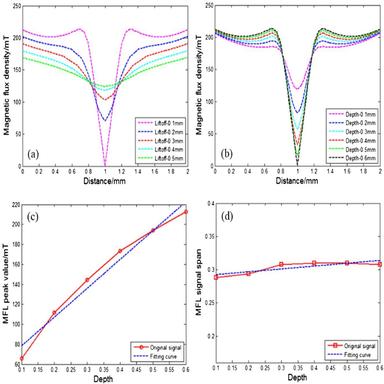
MFL signals and characterizations of triangular defect; (a) MFL signals of triangular defect in different liftoff values with the depth of 0.6 mm; (b) MFL signals of triangular defect in different depths with the liftoff of 0.1 mm; (c) Relationships between MFL peak values in (b) and triangular defect depths; (d) Relationships between MFL signal spans in (b) and triangular defect depths.